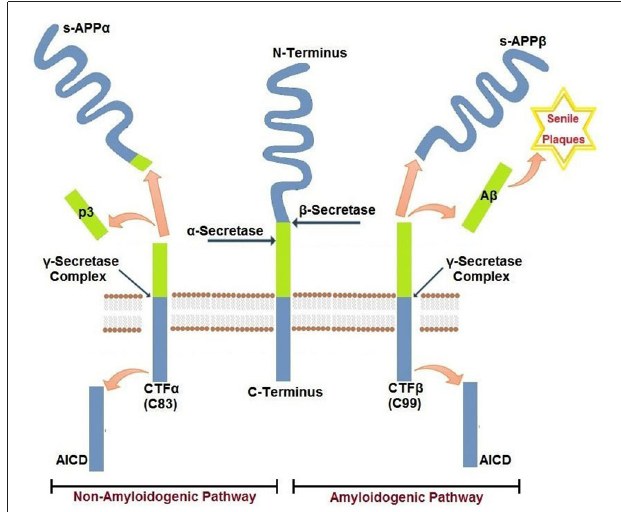
FIGURE 1 | Amyloidogenic and non-amyloidogenic pathways of APP . Amyloid precursor protein APP is a single pass transmembrane glycoprotein. APP may be cleaved by β - γ secretases (amyloidogenic) releasing amyloid A β peptide(s) or by α - γ secretases (non-amyloidogenic). The two pathways are mutually exclusive and are detailed in the